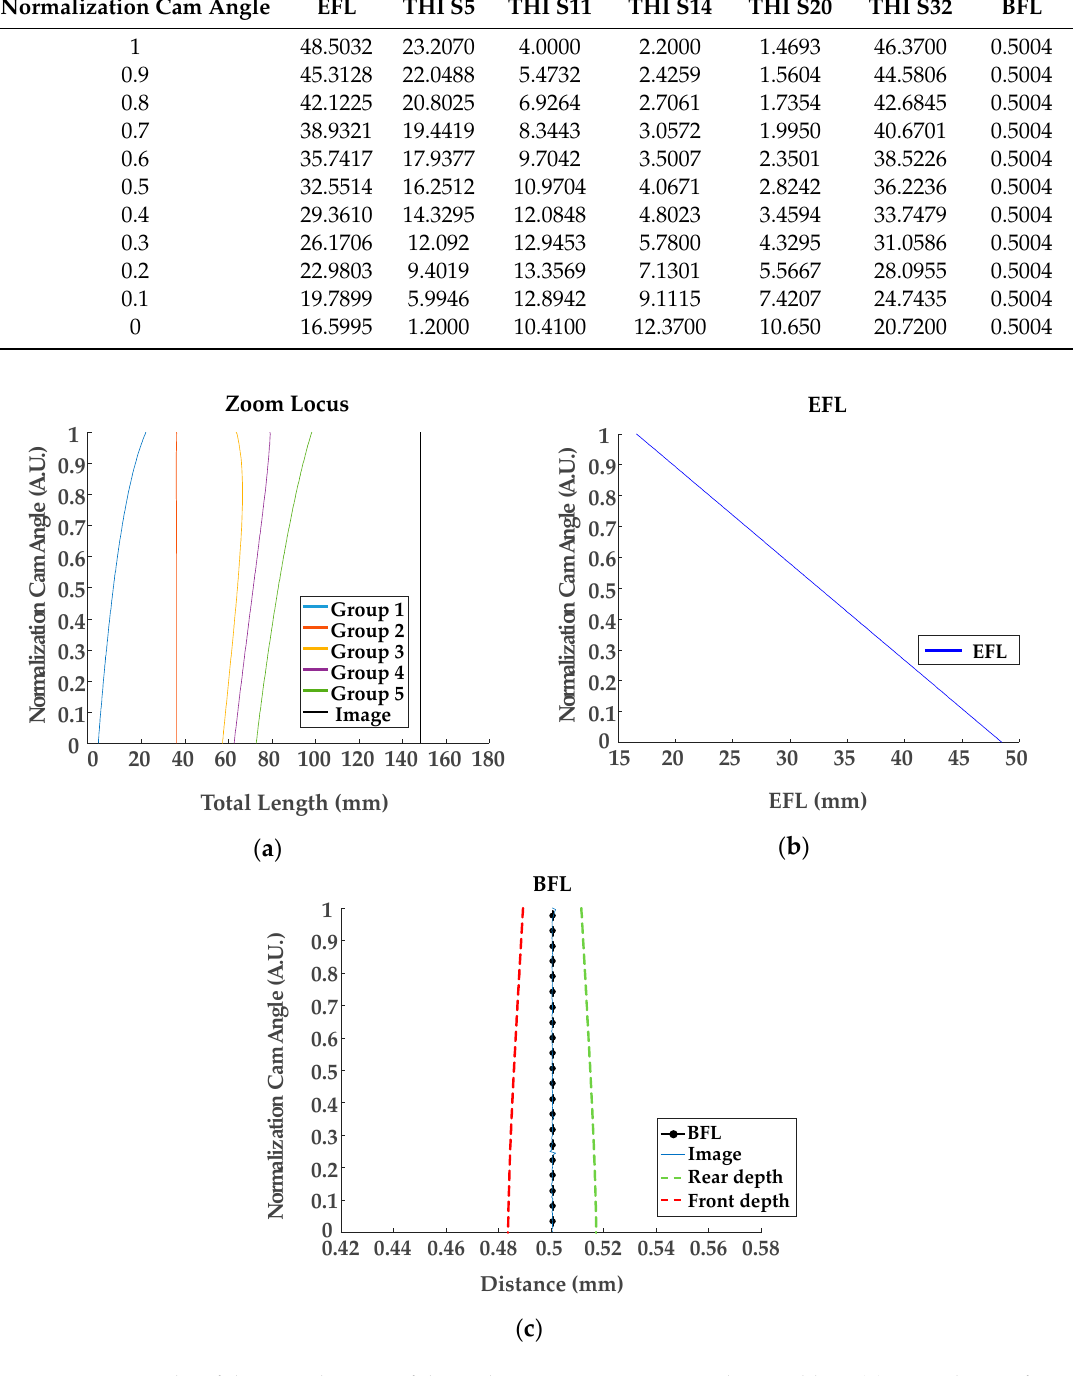
Table 7. Results of reapplying the Pad é approximation to results in Table 6.